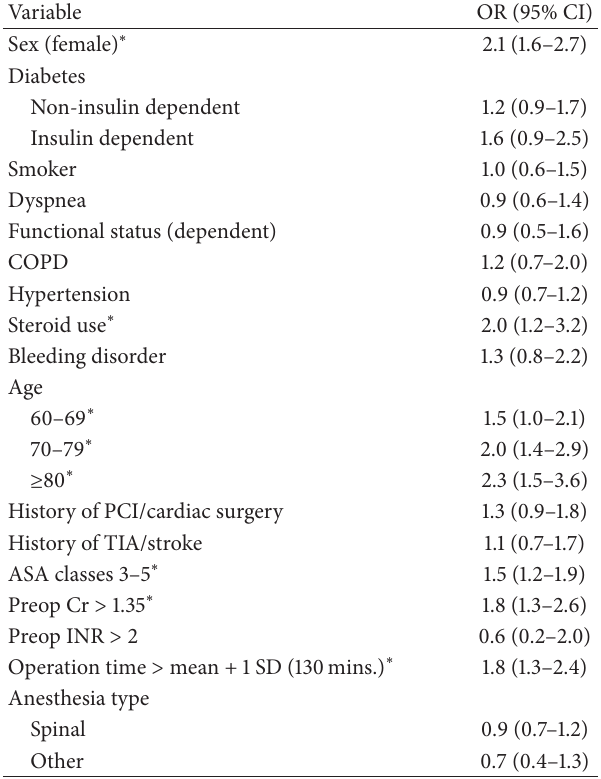
Table 3: Independent risk factors for postop UTI as defined by multivariate logistic